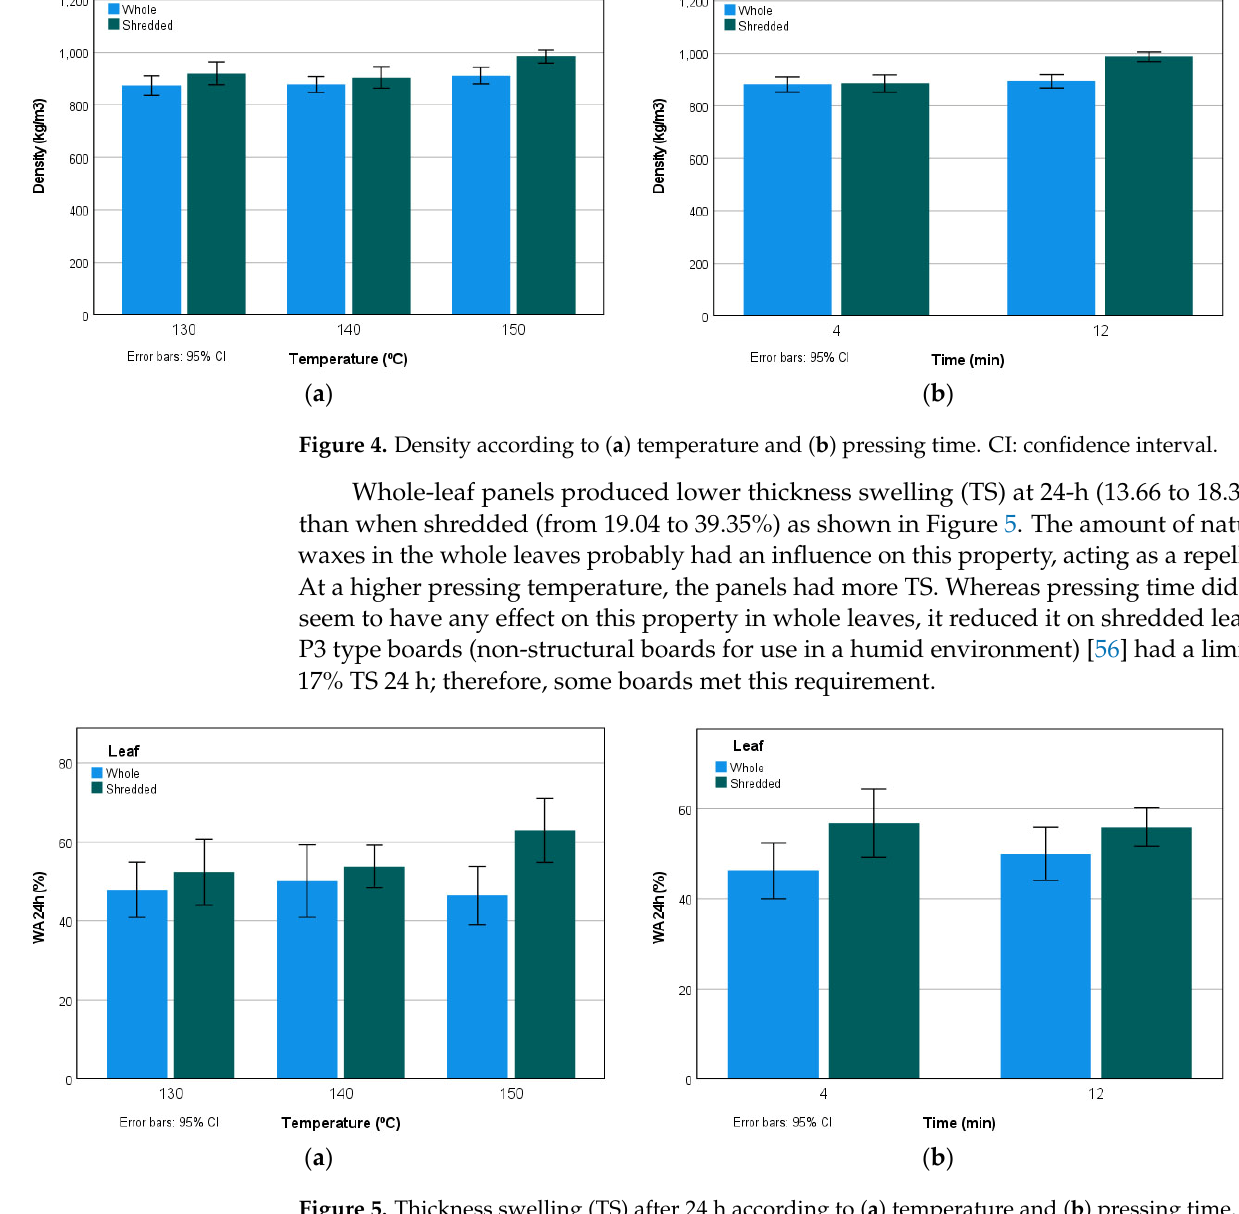
Figure 6. Water absorption (WA) after 24 h according to ( a ) temperature and ( b ) pressing time. Figure 5. Thickness swelling (TS) after 24 h according to ( a ) temperature and ( b ) pressing